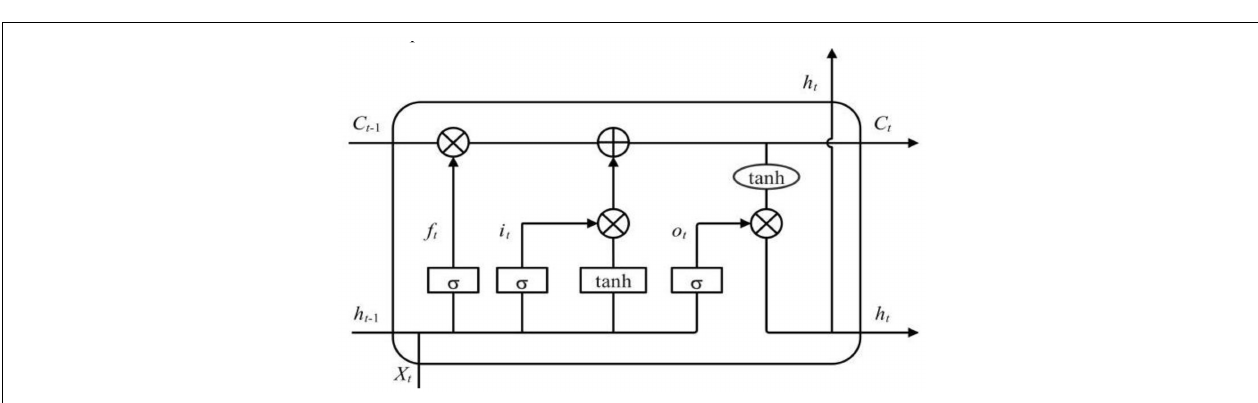
decomposed into a set of multivariate sub-sequences from high frequency to low frequency (IMFis, i = 1, 2, 3, . . .